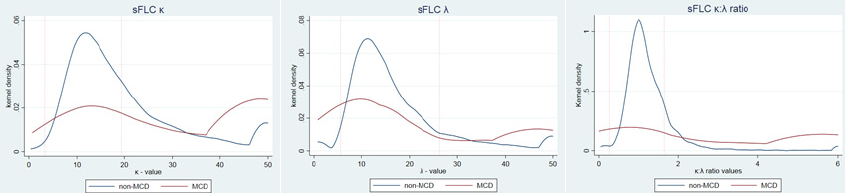
Figure 2. Kernel density of sFLC κ , sFLC λ and the sFLC κ : λ ratio. Kernel density plot depicts the density for sFLC κ , sFLC λ and sFLC κ : λ ratio values for patients with MCD (red line) and patients without MCD (blue line).